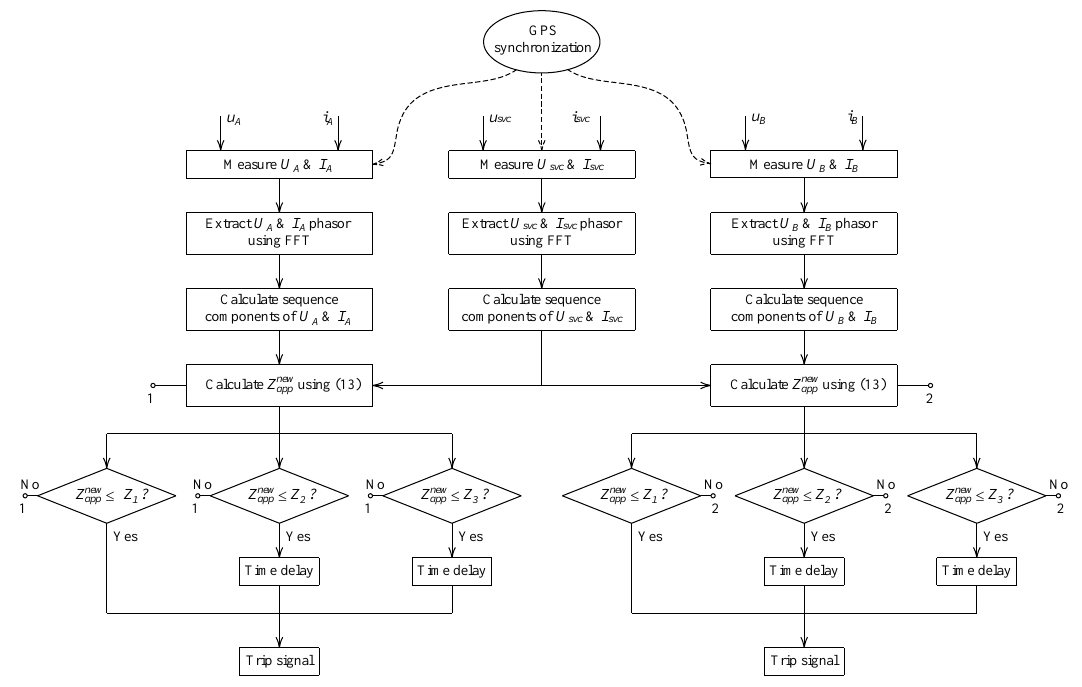
Figure 5. The proposed algorithm for locating fault in transmission line with a